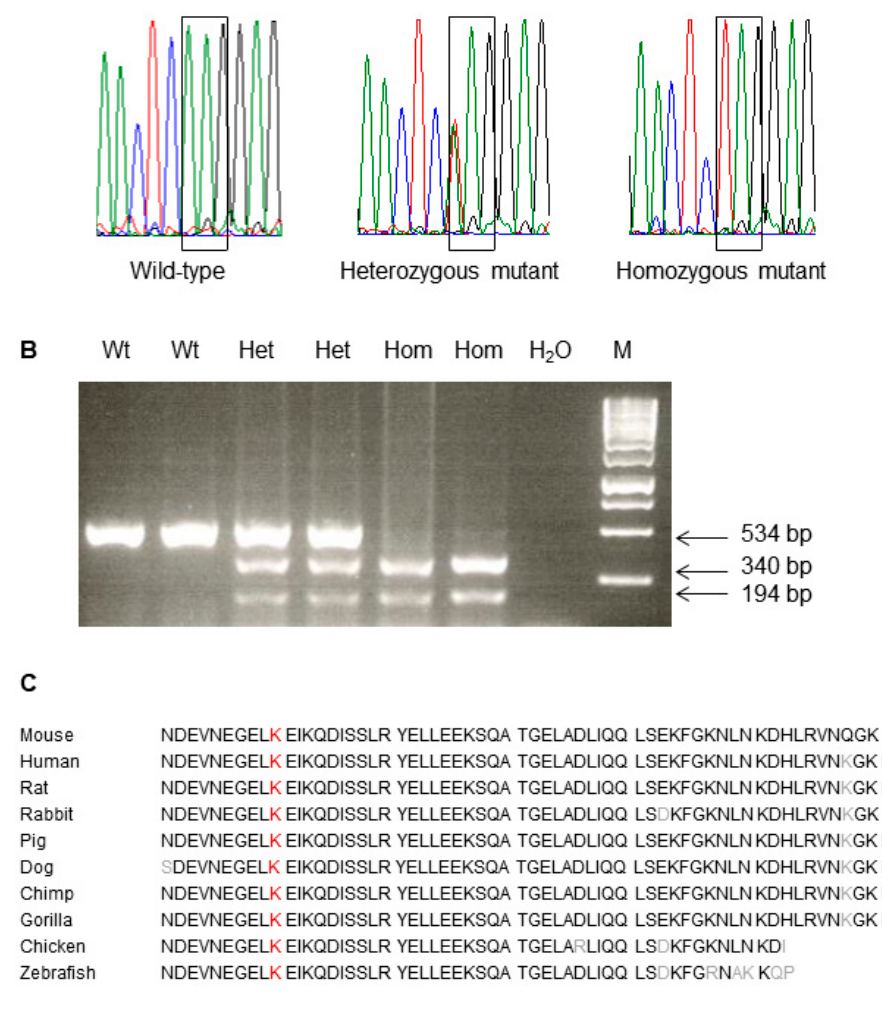
Figure 2. Analysis of the causative point mutation in mutant and wild-type mice of line Trpc7 K810Stop . ( A ) Electropherogram of the causative point mutation. The box shows the AAG → TAG exchange at the amino acid position 810. ( B ) Genotyping of mice by allele-specific PCR-RFLP reaction. FspBI restriction digest of the 534 bp PCR product results in 340 bp and 194 bp fragments of the mutant allele. Hom, Trpc7 K810Stop homozygous mutant; Het, Trpc7 K810Stop heterozygous mutant; Wt, wild- type; M, GeneRuler 1 kb DNA ladder, Thermo Scientific. ( C ) Partial protein sequence alignment (aa 801–862) of murine TRPC7 (Q9WVC5, 862 aa) with other species (http://www.uniprot.org, accessed on 31 August 2021). The amino acid resi- due in red colour shows the position of the Trpc7 K810Stop mutation; non-homologous amino acids are depicted in grey colour.